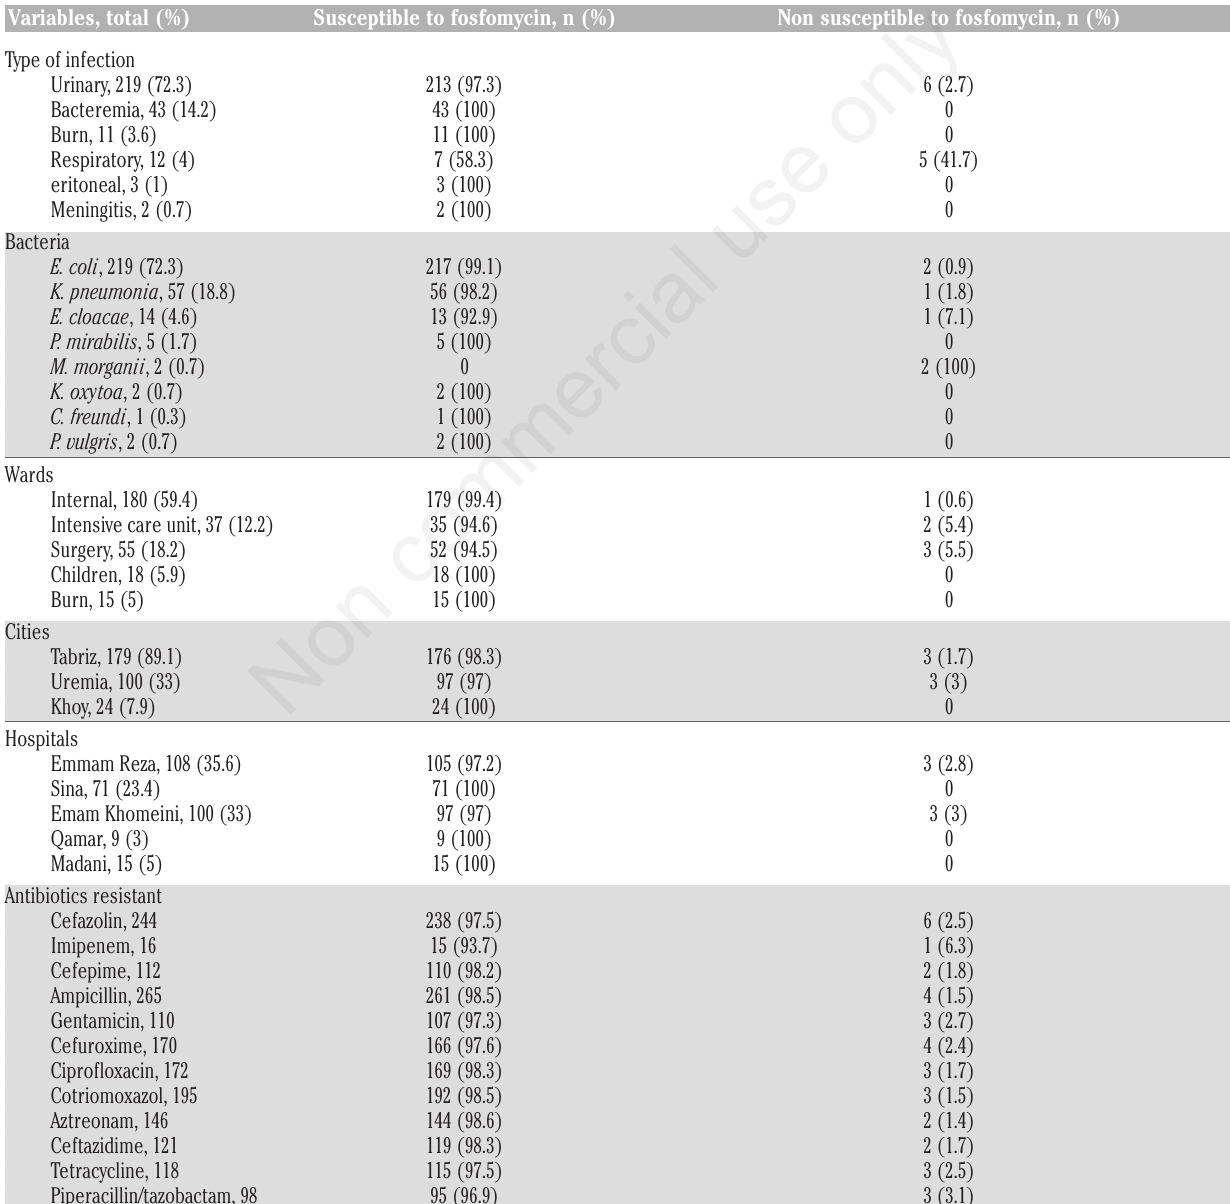
Table 1. Antimicrobial resistance patterns of Enterobacteriaceae to fosfomycin according to source, bacterial isolates, wards, cities, hos- pitals and other tested antibiotics. Variables, total (%) Susceptible to fosfomycin, n (%) Non susceptible to fosfomycin, n (%) Type of infection Urinary, 219 (72.3)